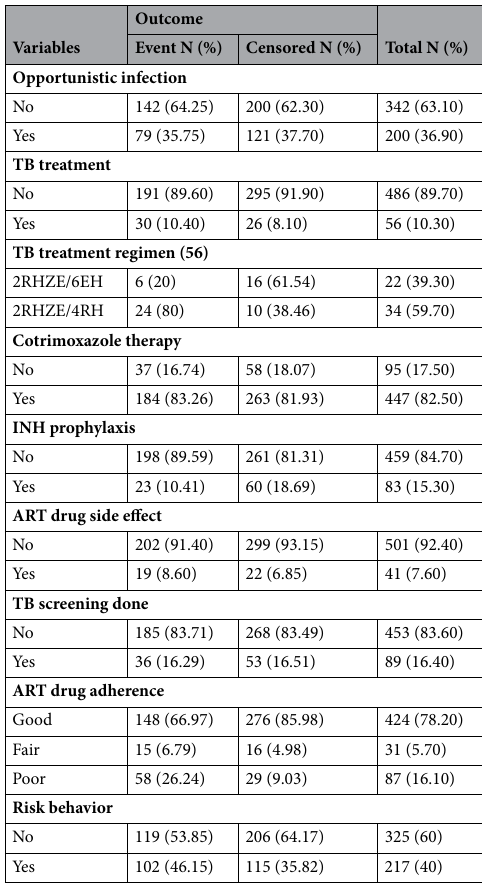
Table 2. Past medical history and drug adherence characteristic of adult HIV patients in Bichena health center, Amhara, North West, Ethiopia, January 1, 2008–December 30,